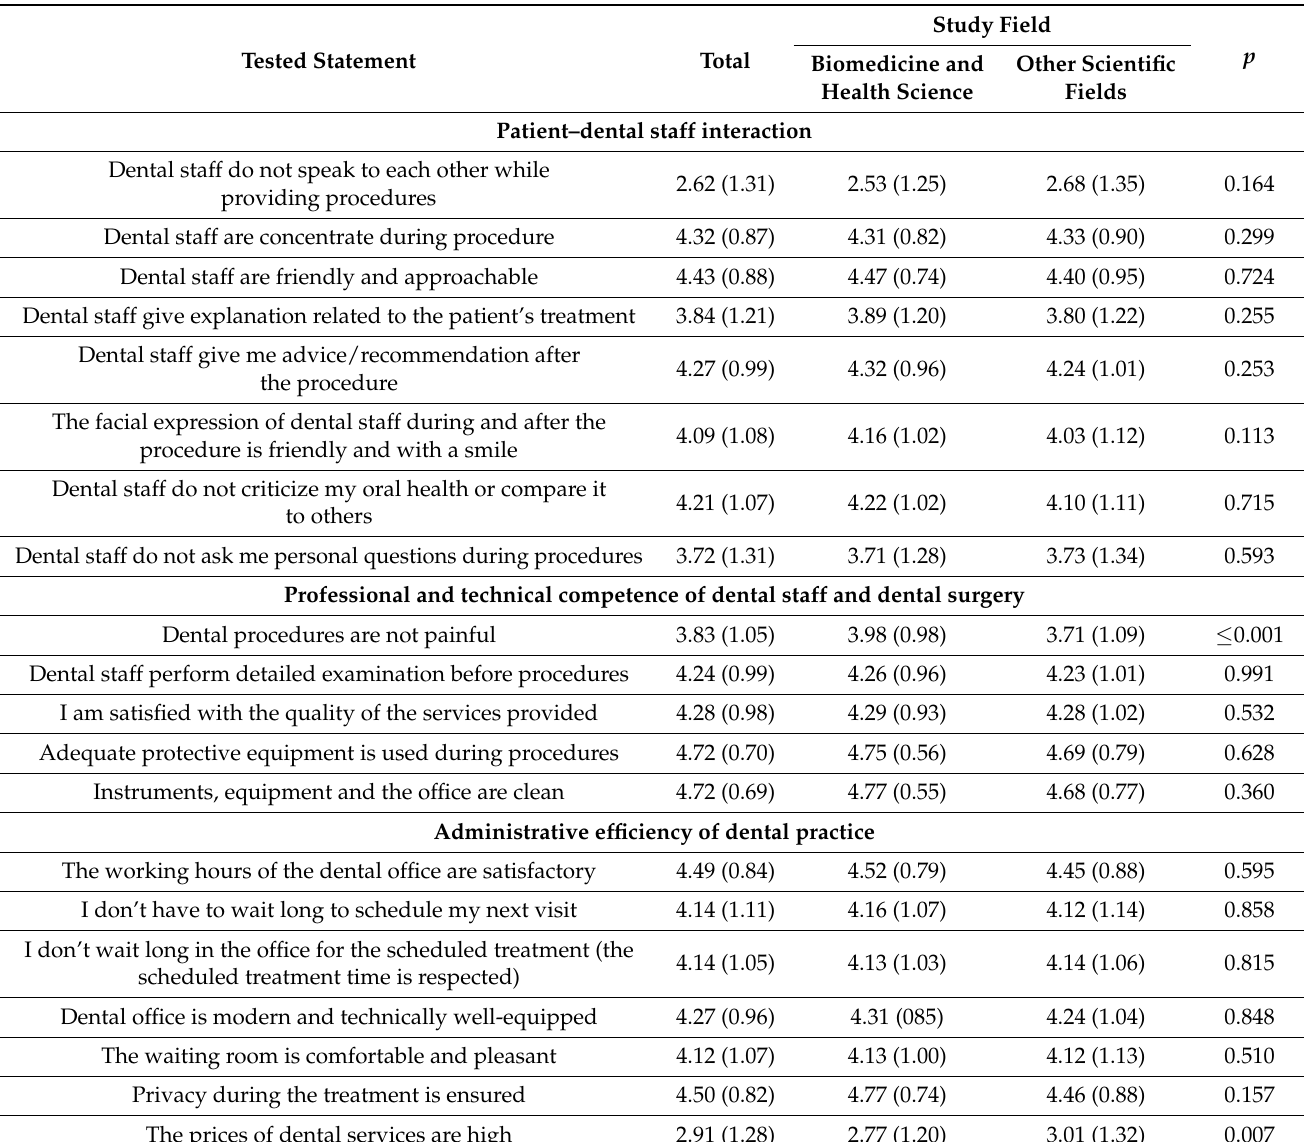
Table 3. Evaluation of respondents’ statements related to primary dental healthcare satisfaction.